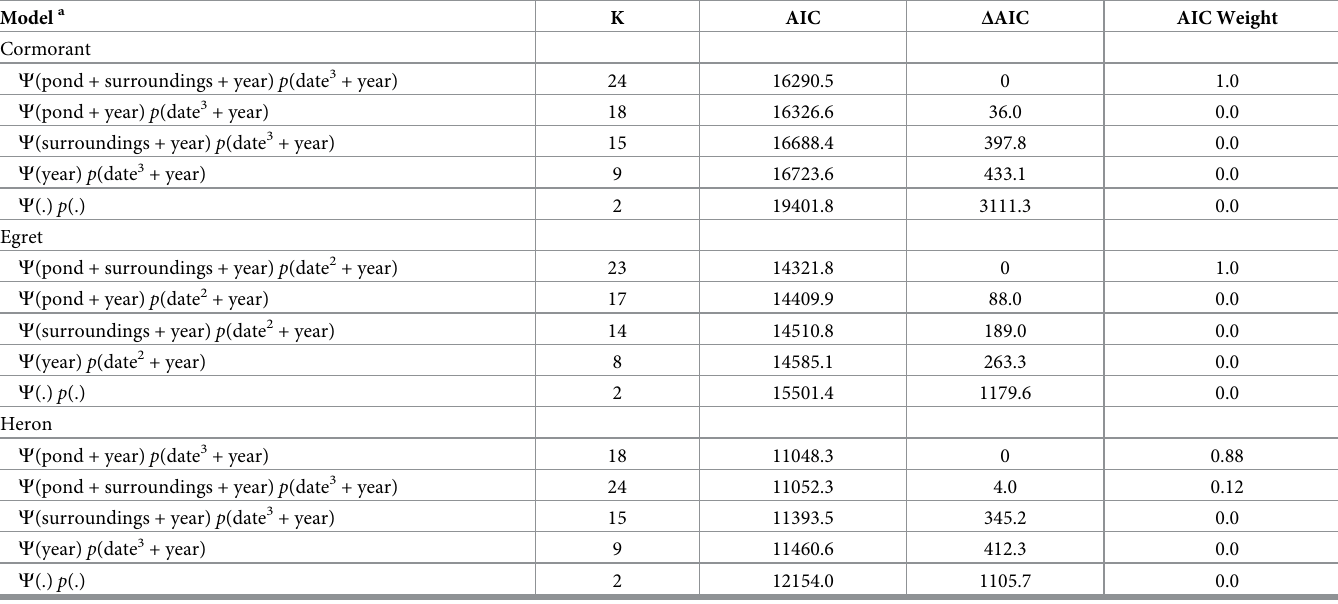
Table 5. Occupancy models ( C ) constructed for cormorants, egrets, and herons using parameters from the top ranked model for detection ( p ). Number of parame- ters (K), AIC, Δ AIC, and models AIC weight are included. Models were constructed using data collected of species presence and absence on catfish ponds in the Mississippi Delta. N = 2,883 ponds for each